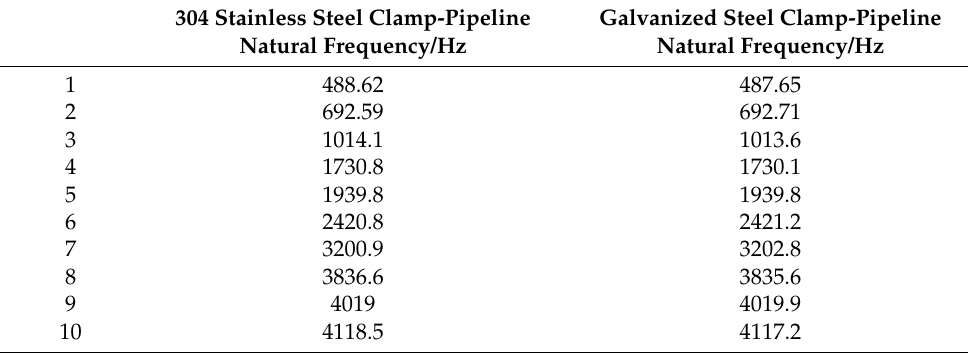
Figure 5. Schematic diagram of fixed constraints.